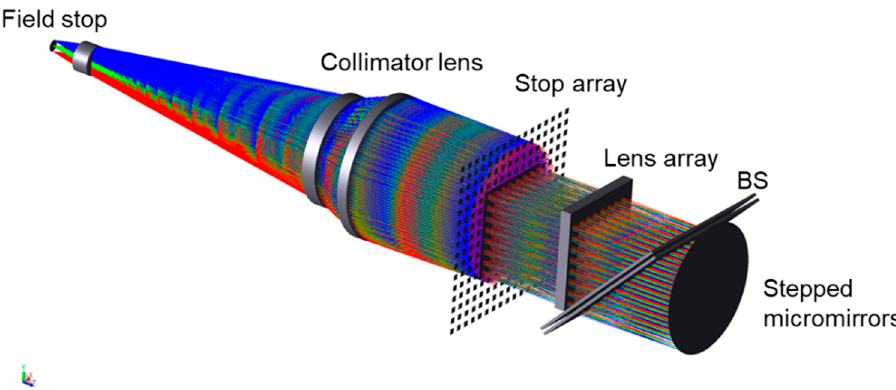
Figure 8. Determining the MS layout by matching the collimator lens and the lens array.